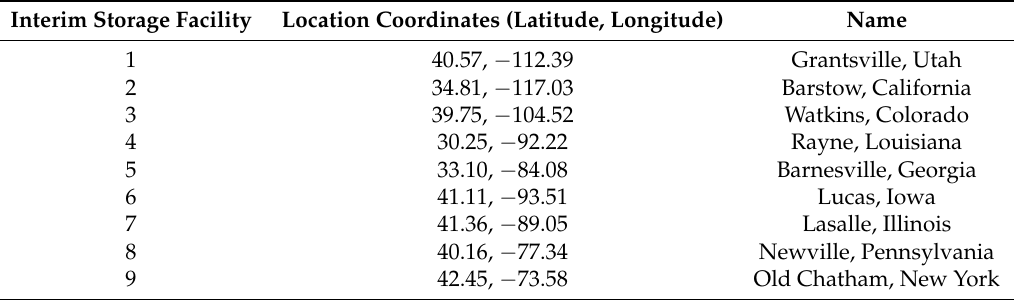
Table A3. Location coordinates of the possible interim storage facility